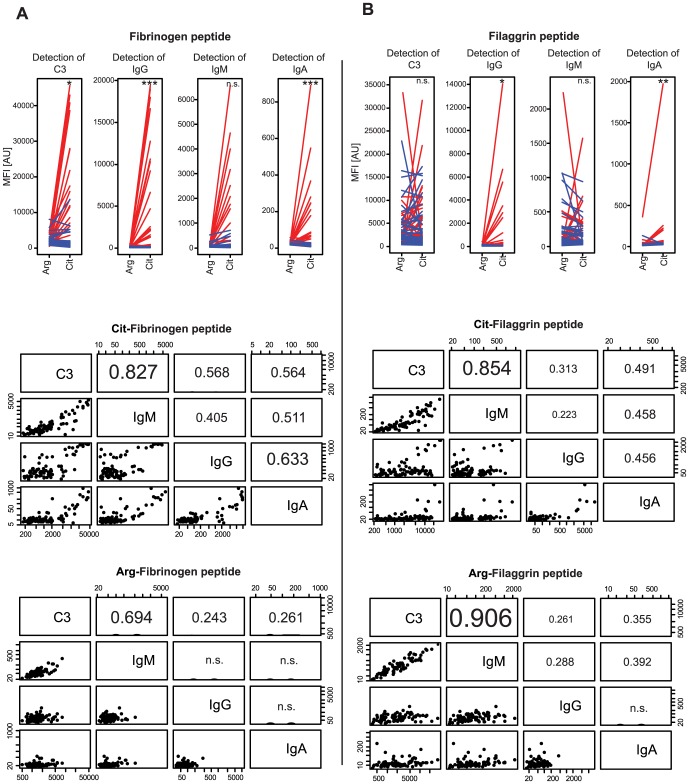
Detection of the level and the complement activating properties of autoantibodies against citrullinated peptides.The arginine or citrulline-containing form of fibrinogen β chain peptide (SGSG60RPAPPPISGGGYRAR74 vs. SGSG60XPAPPPISGGGYXAX74) (A) and filaggrin peptides (454TRGRS458K vs. 454TXGRS458K) (B) were coupled on beads and incubated with serum samples to detect peptide-specific IgG, IgM, IgA autoantibody levels and their complement activating properties. Median fluorescent intensity (MFI) values for arginine or citrulline-containing forms of the peptides in RA patient group (red lines) or the control group (blue lines) are shown in the upper panel. Significance level of differences between controls and RA patients were calculated only for the citrullinated peptides by Mann-Whitney test and the p-values are indicated in the upper panel as follow: * p-value<0.05; ** p-value<0.01, ***p-value<0.001. Spearman's Rho correlation coefficients calculated between anti-C3, anti-IgG, anti-IgM and anti-IgA MFI values are shown for citrullined (middle panels) or native (lower panels) form of the peptides, where non-significant correlations are indicated by (n.s.).